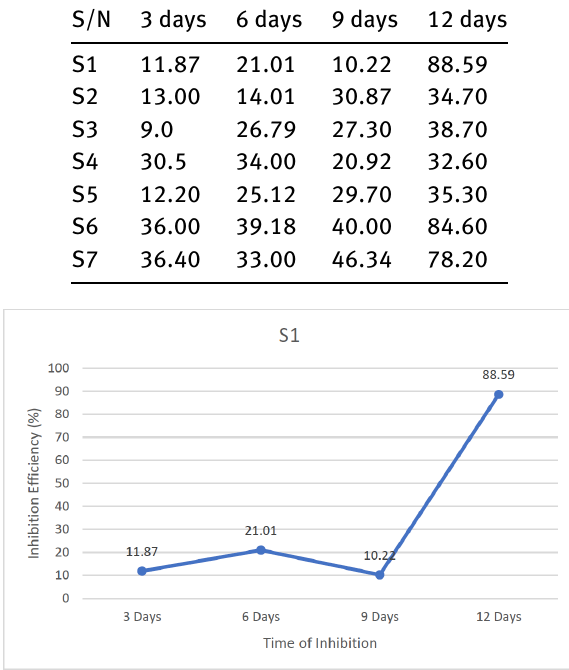
Table 5: Result of inhibition eflciency (%).